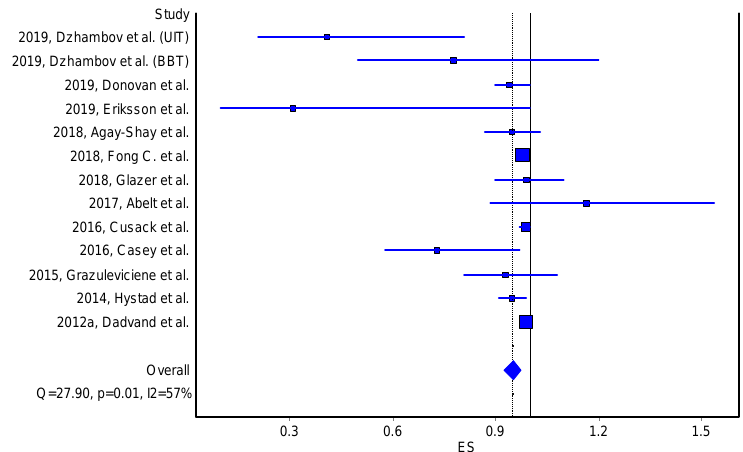
Figure 2. Forest plot on the effect of residential greenness (NDVI) on small for gestational age (odds ratios, quality effects model). Note: ES—effect size; Q and I2—heterogeneity statistics. Horizontal lines, square and diamond symbols are indicating confidence intervals, effect estimates and overall effect, respectively.